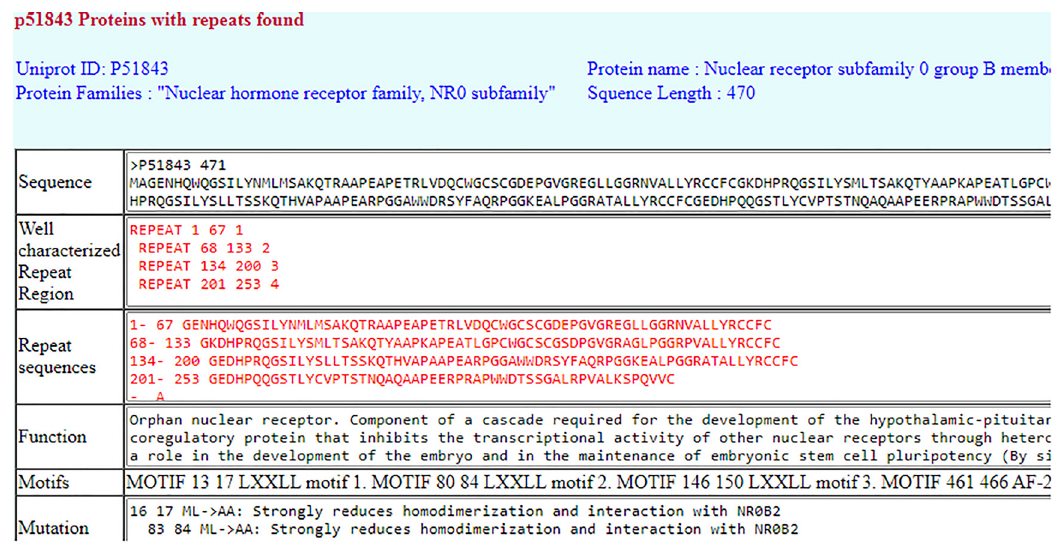
Figure 5: The output repeat result obtained for a Nuclear receptor subfamily 0 group B member 1 (P51843) by using HRPEP